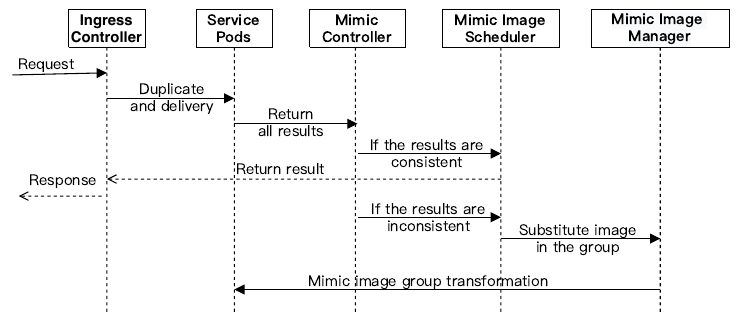
Figure 3. The diagram of the MDSF working